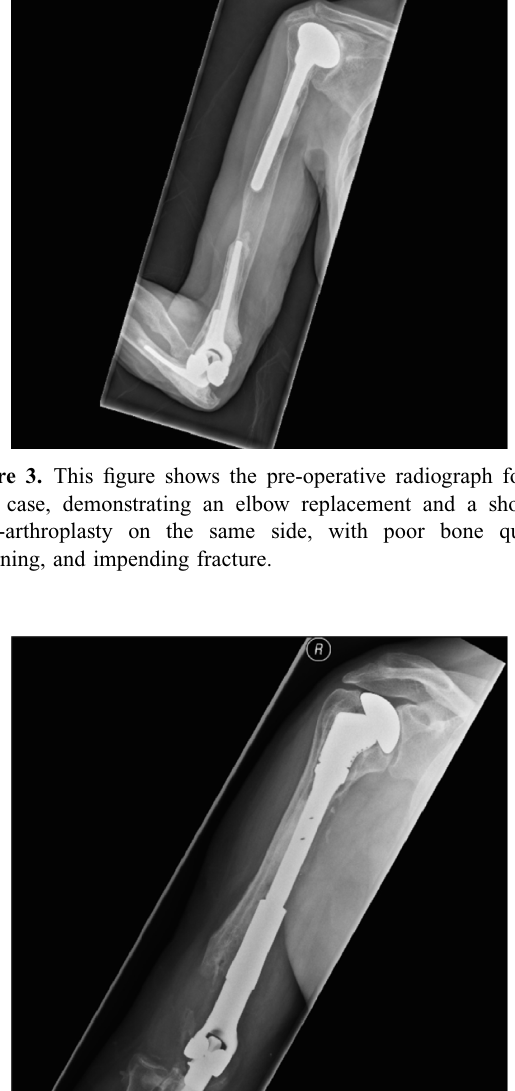
elbow prosthetic hinge.